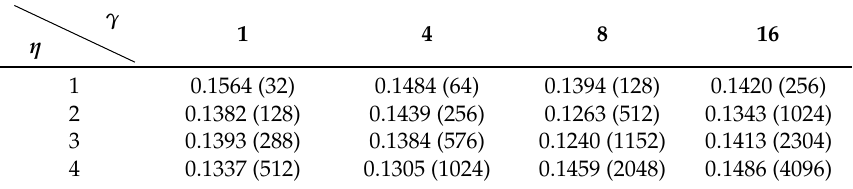
Table 1. The analysis of using some different settings of γ and η to calculate feature descriptors. The values in the brackets are feature descriptor (HOG + HOF + MBHx + MBHy)